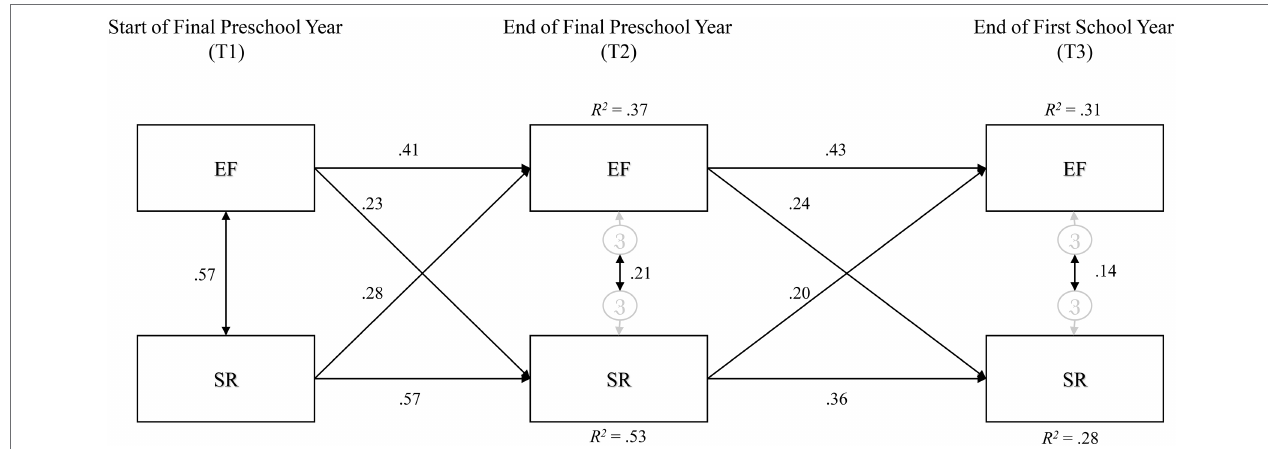
FIGURE 1 | Model 1: cross-lagged panel model of EF and SR. Path loadings are standardized regression weights. EF, executive function composite index and SR, self-regulation composite